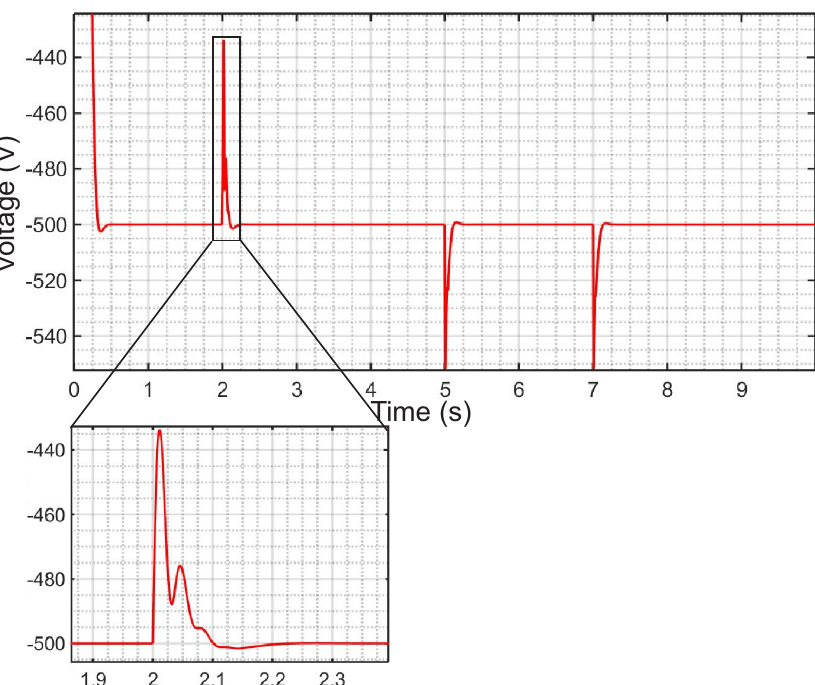
Figure 12. Bus voltage during charging and discharging.